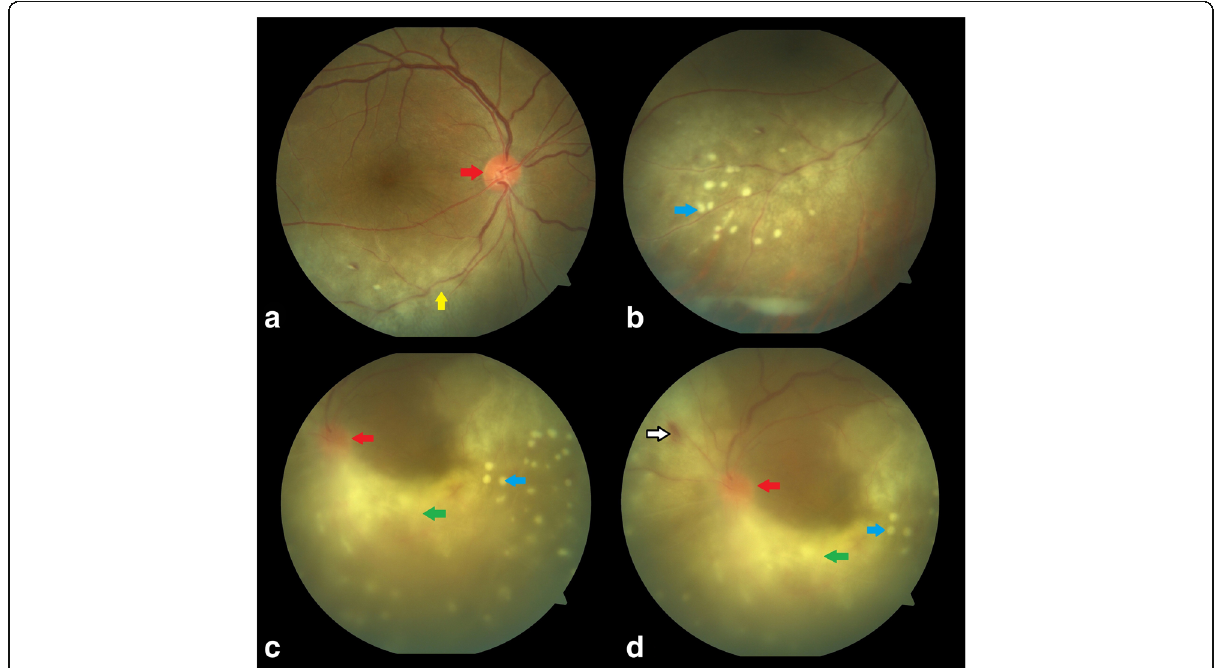
Fig. 2 Color fundus photo of a , b the right eye showing hyperemic disc (red arrow) with ground glass retinochoroiditis (yellow arrow) and superficial retinal precipitates (blue arrow) along the inferotemporal arcade and c , d the left eye showing dense vitritis (green arrow) with hyperemic disc (red arrow), intraretinal hemorrhage (white arrow with black border) superonasal to the disc, and superficial retinal